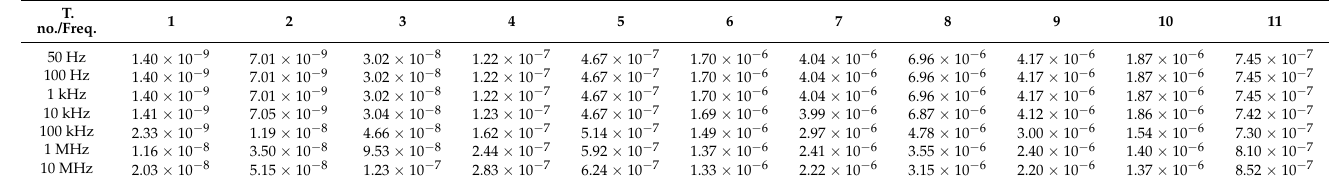
Table A7. Self and mutual inductances of turn 11 (in H) resulting from FEM simulations. T. no./Freq.